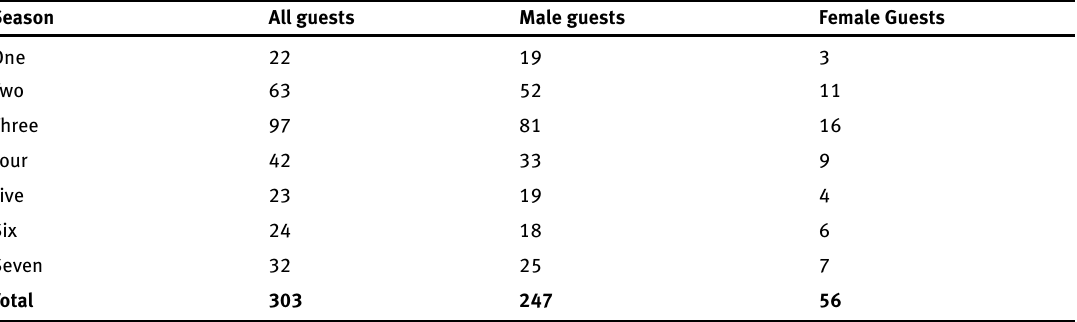
Table 2: Celebrity guest appearances per season, seasons 1-7. (Some guests appear in multiple episodes and seasons.) Season All